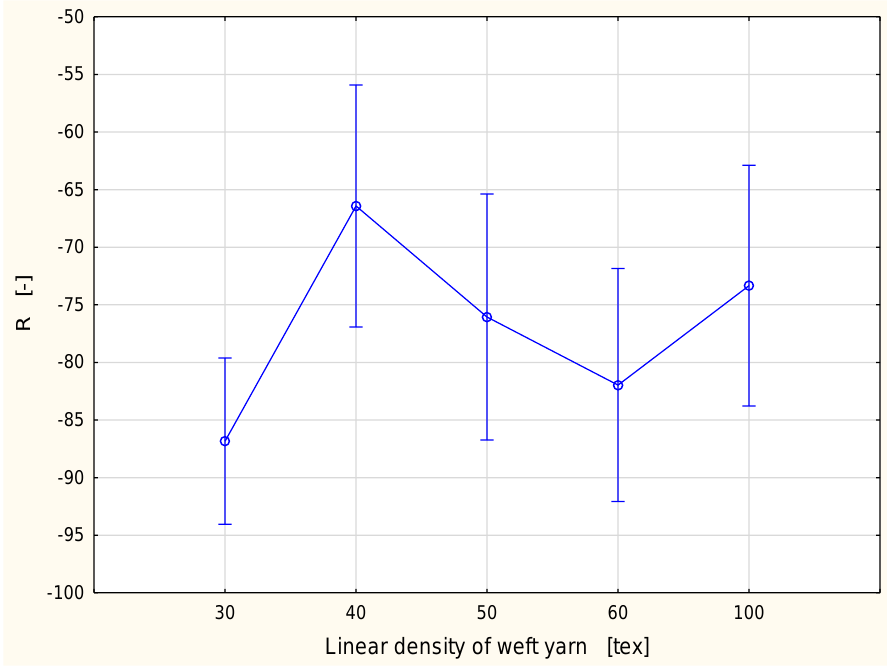
Further thickening of the weft yarn caused a more clear decrease in the OMMC value. According to the classification rules proposed by the MMT manufacturer [33], all fabric variants can be assessed as poor from the point of view of liquid moisture management. Figure 14. Accumulative one-way transport index vs. linear density of the weft yarn. The differences between the fabric variants investigated are in the range of the poor class. The OMMC (overall moisture management capacity) was calculated using the for- mula presented in the AATCC Test Method 195-2017 [34]. The parameter was based on the absorption rate for the bottom surface, the spreading speed for the bottom surface, and the one-way transport capability. The weights of abovementioned parameters were established based on human perception studies. The value of the OMMC parameter can be in the range 0 – 1. The higher the value of the OMMC parameter is, the better the ability of fabrics to manage liquid moisture. In the case of the investigated cotton fabrics, their ability to manage liquid moisture decreased with the increase of the linear density of the weft yarn (Figure 15). The best result was achieved for the fabric with the 30 tex weft yarn, the worst for the fabric with the 100 tex weft yarn. The drop in the OMMC parameter value was not too great in the range of the weft yarn linear density from 30 tex to 50 tex.